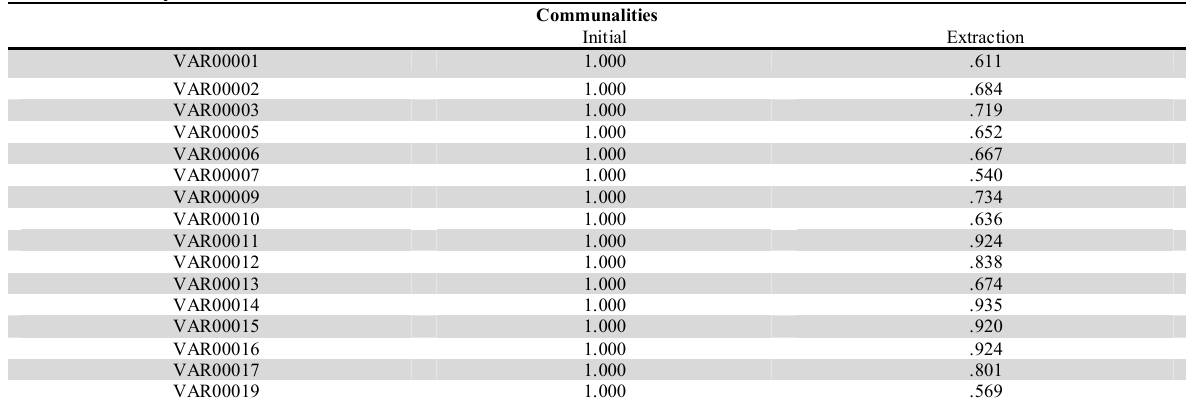
The summary of communalities